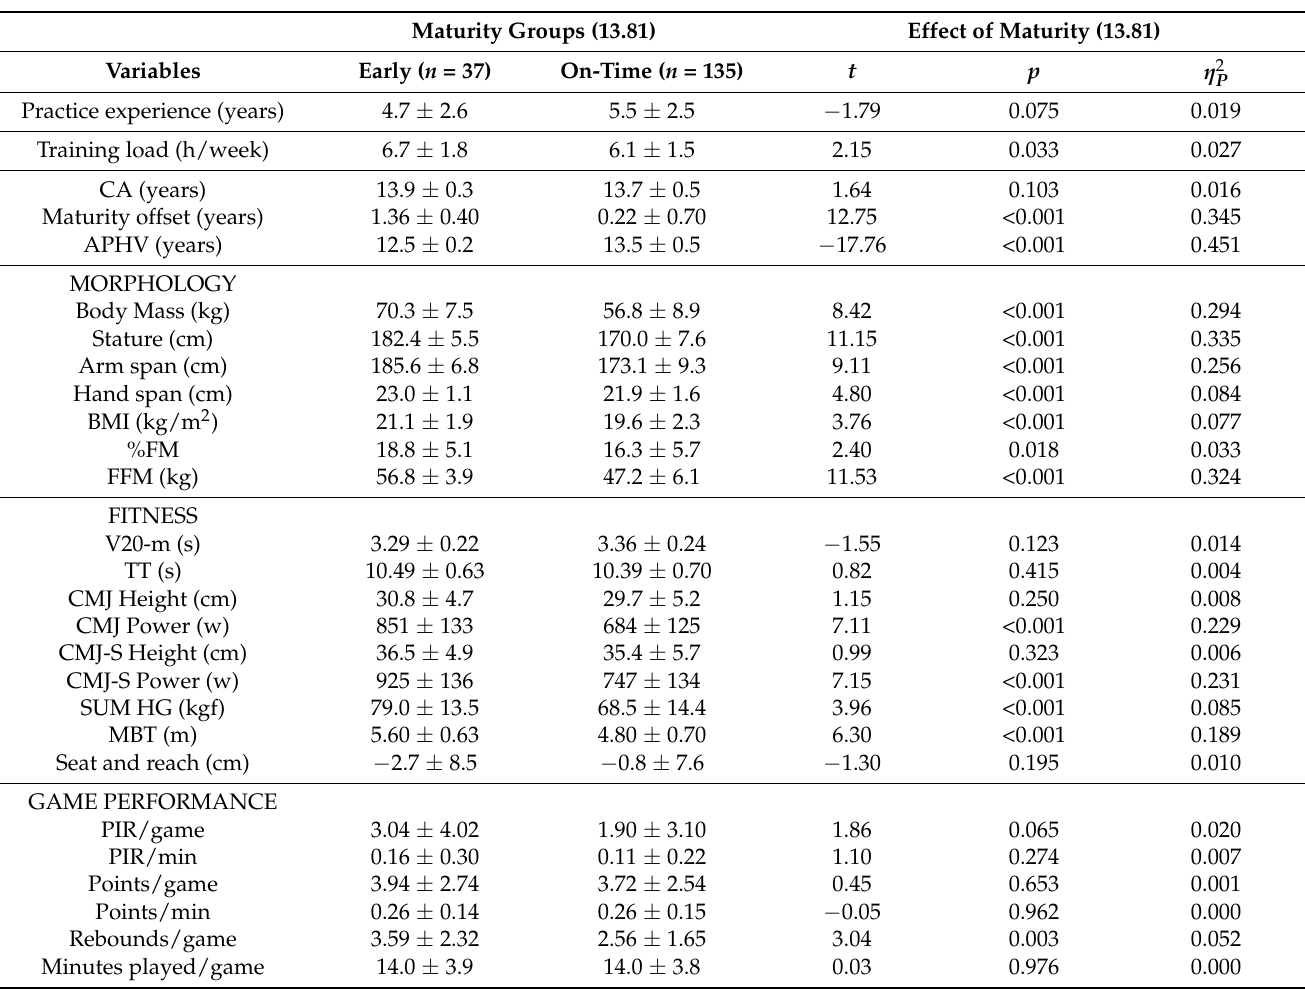
Table 3. Descriptive statistics (mean and standard deviation) and results of independent samples t-tests and Kruskal-Wallis